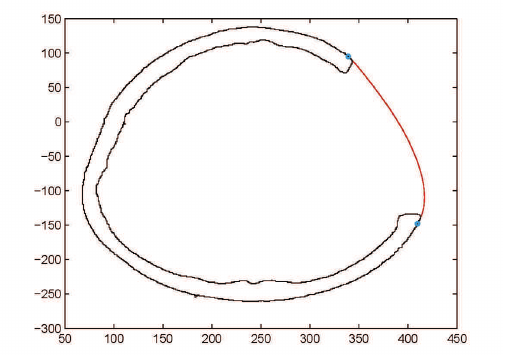
Figure 13. Construction of fractured part curve using C 1 rational Ball curves.